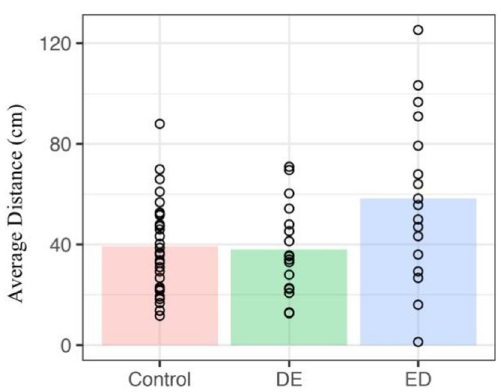
Figure 2. Depicts both the average nose-to-nose difference (in cm) as a function of group (coloured bars), along with the individual data points illustrating each participant’s preferred social